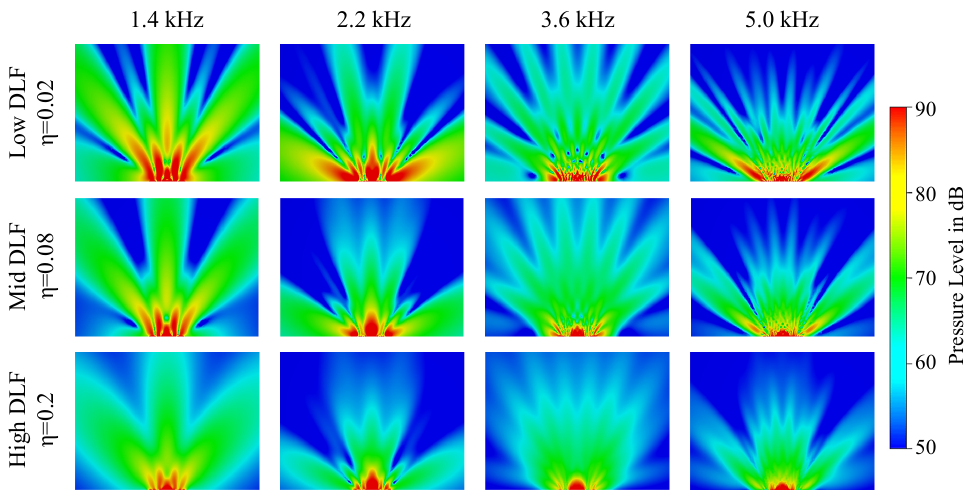
Figure 10. Simulated frequency-dependent radiation of a panel with different damping loss factors applied. With increased damping, the off-axis radiation is